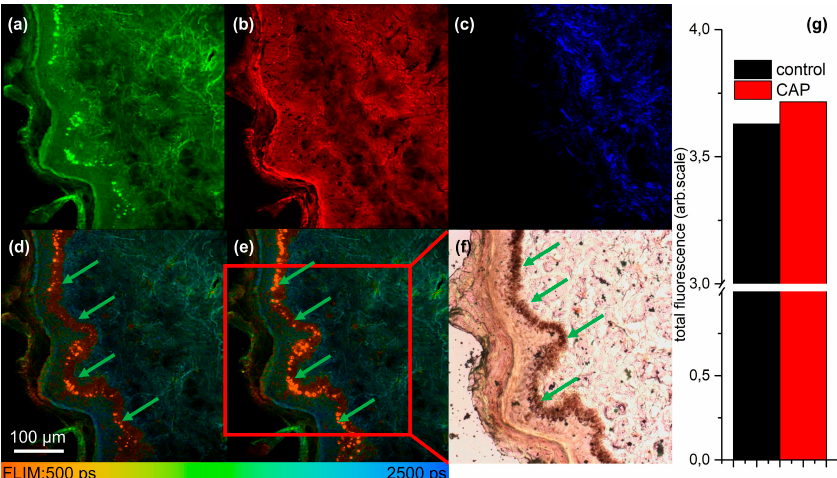
Figure 2. Multimodal nonlinear imaging of a human skin tissue sample before (panels a–d) and after cold atmospheric plasma (CAP) treatment for 20 s using the kINPen-device with an Ar–oxygen mixture (panel e). ( a ) TPEF image, excitation at 672.5 nm and 832.2 nm due to simultaneous CARS imaging using these wavelengths as pump and Stokes, emission 426–490 nm; ( b ) CARS image at 2850 cm − 1 ; ( c ) SHG image at 415 nm; ( d ) 2P-FLIM image for the same parameters as in ( a ) before CAP treatment, the green arrows mark melanocytes within the stratum basale; ( e ) 2P-FLIM image for the same parameters as in ( a ) after 20 s of CAP treatment using the kINPen MED ® -device with an Ar–oxygen mixture revealing an overall increase in fluorescence, particularly in the melanocytes inside the stratum basale, indicated by green arrows; ( f ) brightfield microscopic image of AgNO 3 staining for melanin proving localization of the CAP-induced increase of autofluorescence within the melanocytes inside the stratum basale, marked by green arrows. ( g ) total fluorescence signal before and after CAP treatment. The fluorescence intensity increases in this case by 2%, typically the increase is larger, see Figure 4a.